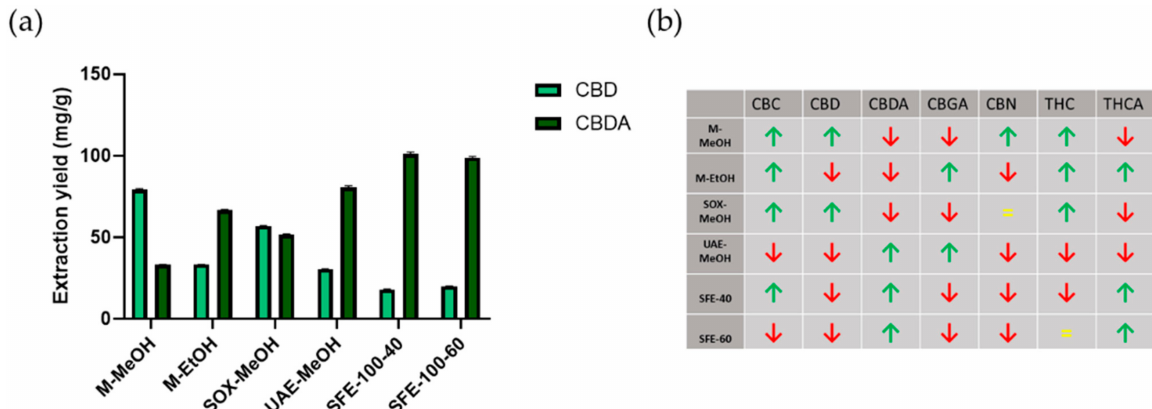
Figure 2. Comparison of cannabinoid extraction yields with different extraction methods. Panel ( a ) shows the amounts of CBD and CBDA obtained with different extraction methods (data are means ± SD from n = 3 replicate measurements), and panel ( b ) shows the trends of all cannabinoids analysed across extraction methods tested compared to the average (= means as the average, ↑ above average, and ↓ below